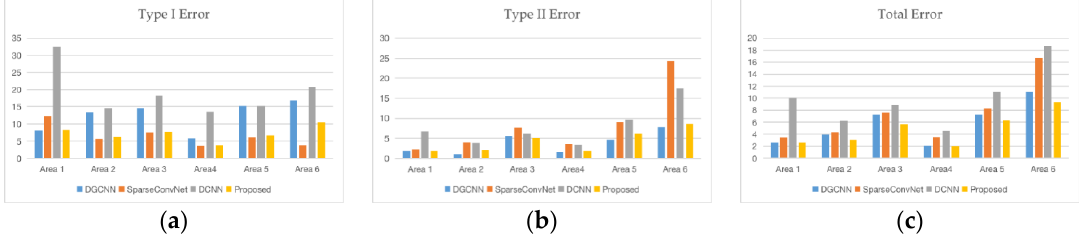
Figure 11. Comparison of DGCNN, SparseConvNet, DCNN, and proposed network on dataset III: ( a – c ) represent the type I error, type II error, and total error, respectively.